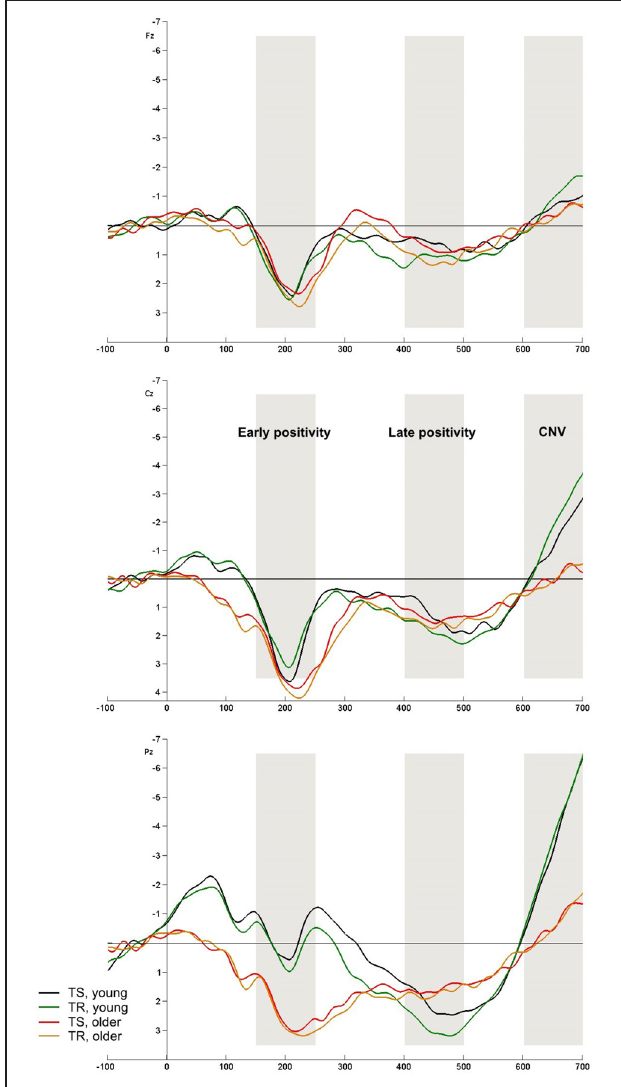
FIGURE 4 | Cue-locked ERPs at Fz, Cz, and Pz electrodes. TS and TR for color and shape classification task in young (TS – black, TR – green) and older (TS – red, TR – orange) groups. The analyzed components are indexed by rectangles: early positivity, late positivity and early CNV.